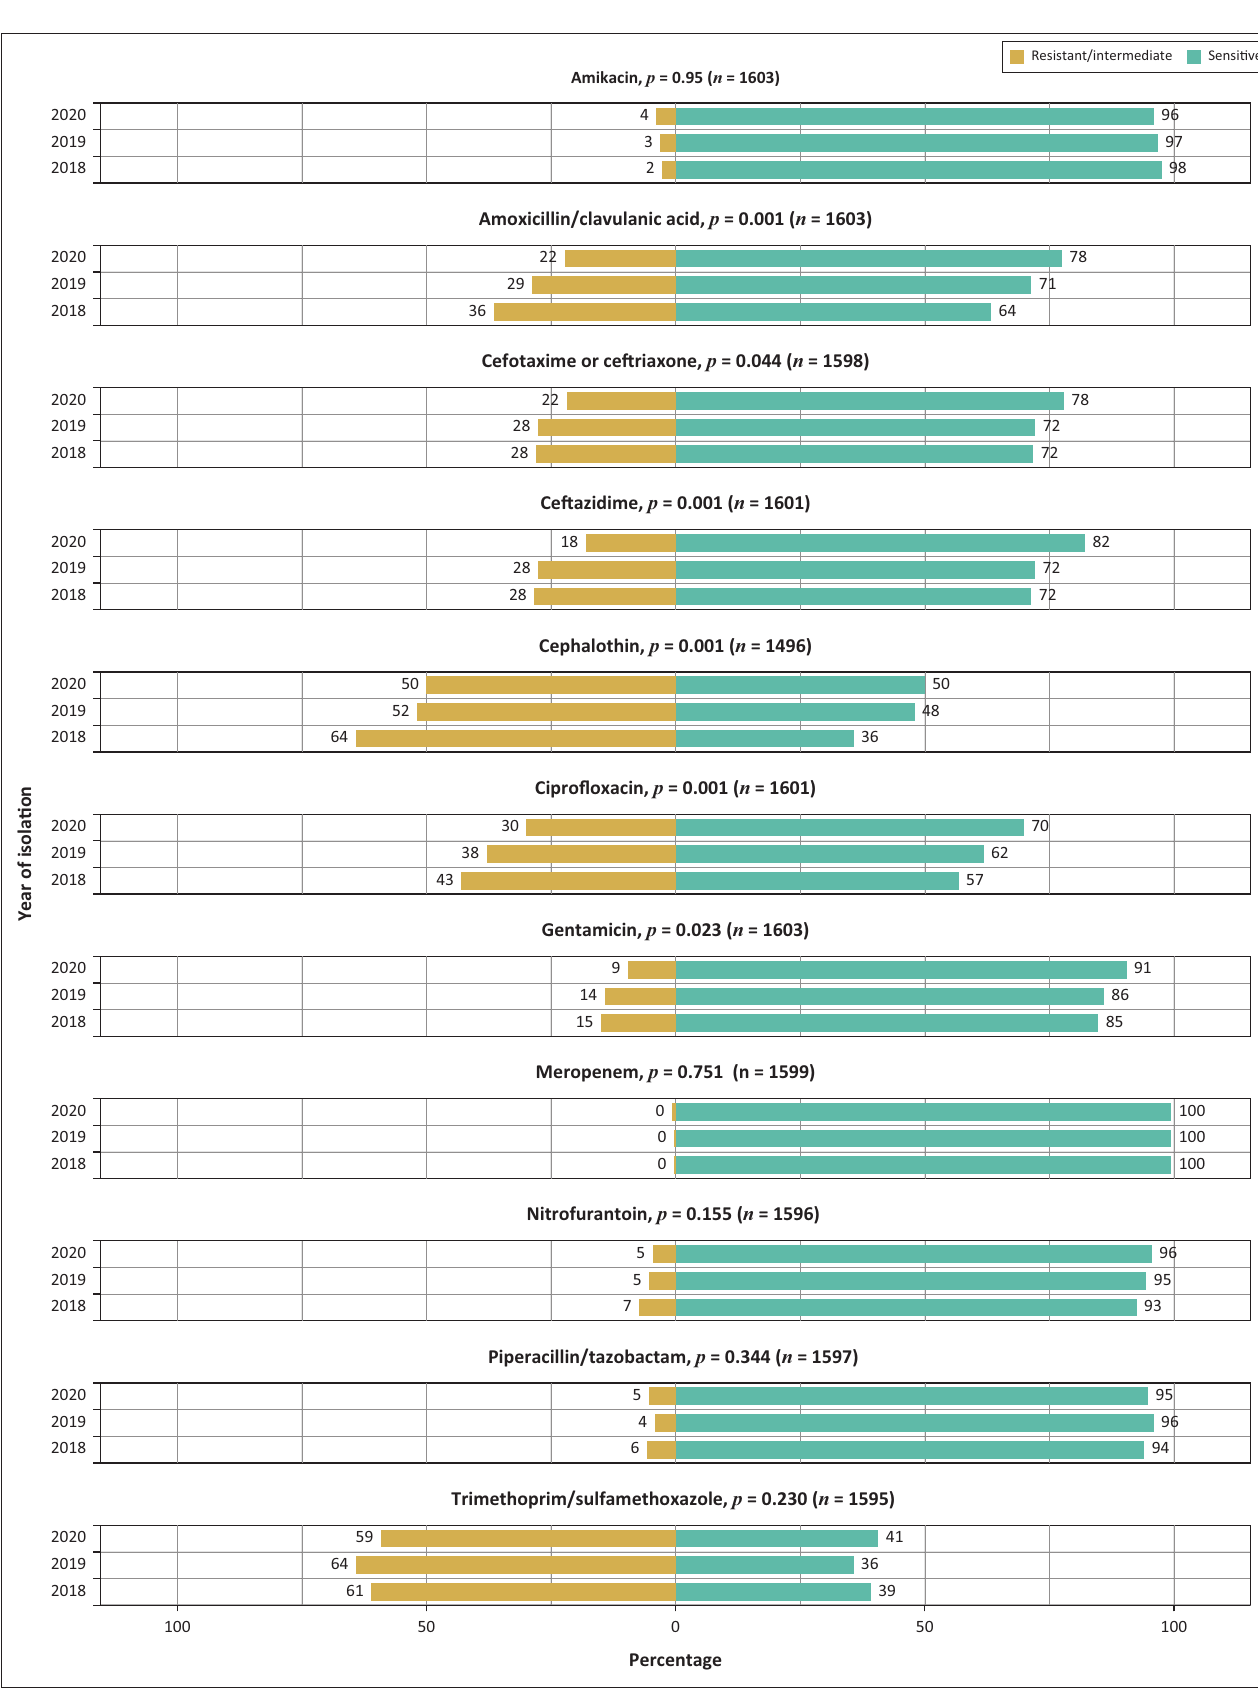
FIGURE 3: Antimicrobial susceptibility trends of E. coli isolated from patients with suspected urinary tract infections at the RK Khan Hospital, Durban, KwaZulu-Natal, South Africa, January 2018 – December 2020. The total number of isolates is different for each antimicrobial due to missing results linked to random terminations that can sometimes occur during automated antimicrobial susceptibility testing with the VITEK ® 2